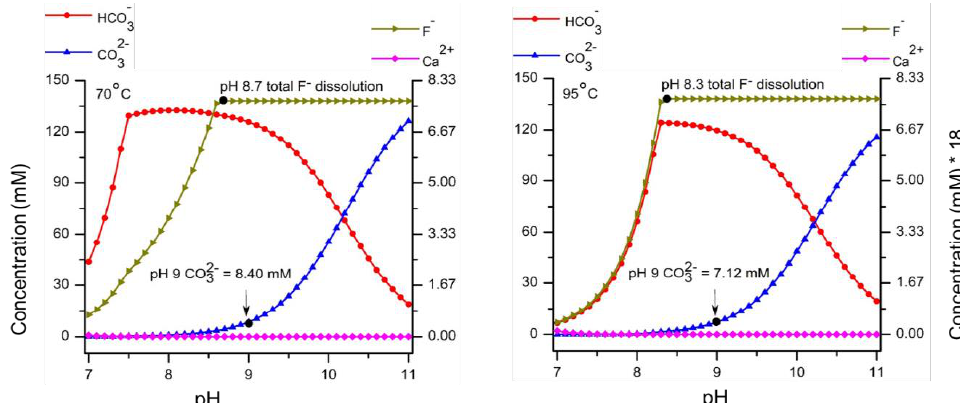
Figure A1. Thermodynamic calculation with 150mM Na 2 CO 3 and 300 mg/L CaF 2 from pH range 7–11 and temperature (70 and 95 °C).